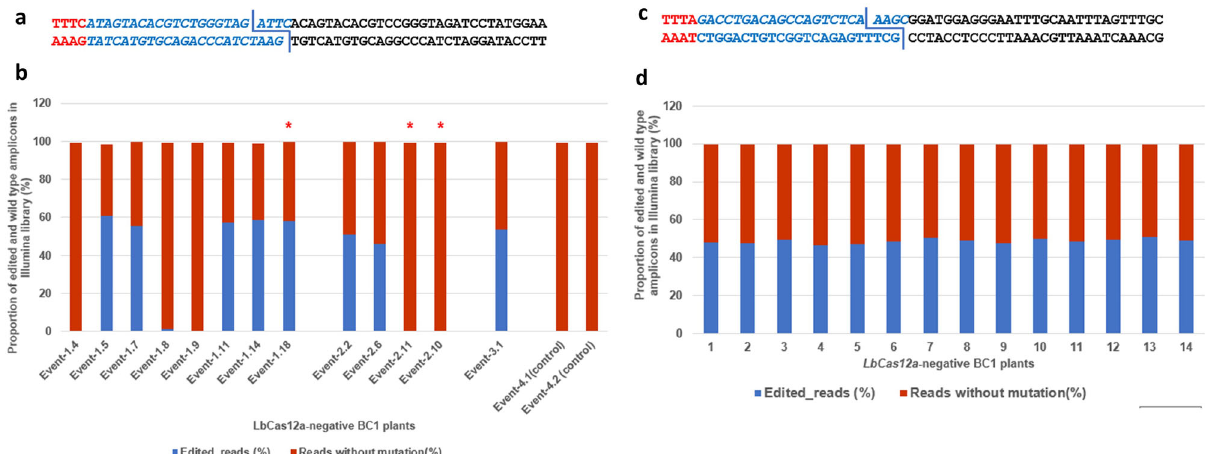
Fig. 3 Analysis of DNA editing patterns at the sites of targeted CO in the BC1-F1 plants identi fi ed in the genome editing experiments with gRNA1 and gRNA2 using Illumina sequencing. DNA was isolated from a single leaf disc sampled from each BC1-F1 plant for library construction and sequencing. Each bar on the graph represents a result derived from a single BC-F1 plant ( n = 1). a The gRNA1 target site showing LbCas12a cutting pattern: the PAM sequence (red); gRNA target sequence (italic blue); a fragment of the downstream DNA sequence (black). b The graph shows the proportion of edited (blue) and non- edited (red) reads in 13 LbCas12a negative BC1-F1 plants with the targeted CO and two control plants. BC1-F1 plants selected for further characterization are highlighted with red stars (*) c The gRNA2 target site showing LbCas12a cutting pattern; d The graph shows the proportion of edited (blue) and non-edited (red) reads in 14 randomly selected LbCas12a negative BC1-F1 plants with targeted CO derived from F1-T0 by Parent A